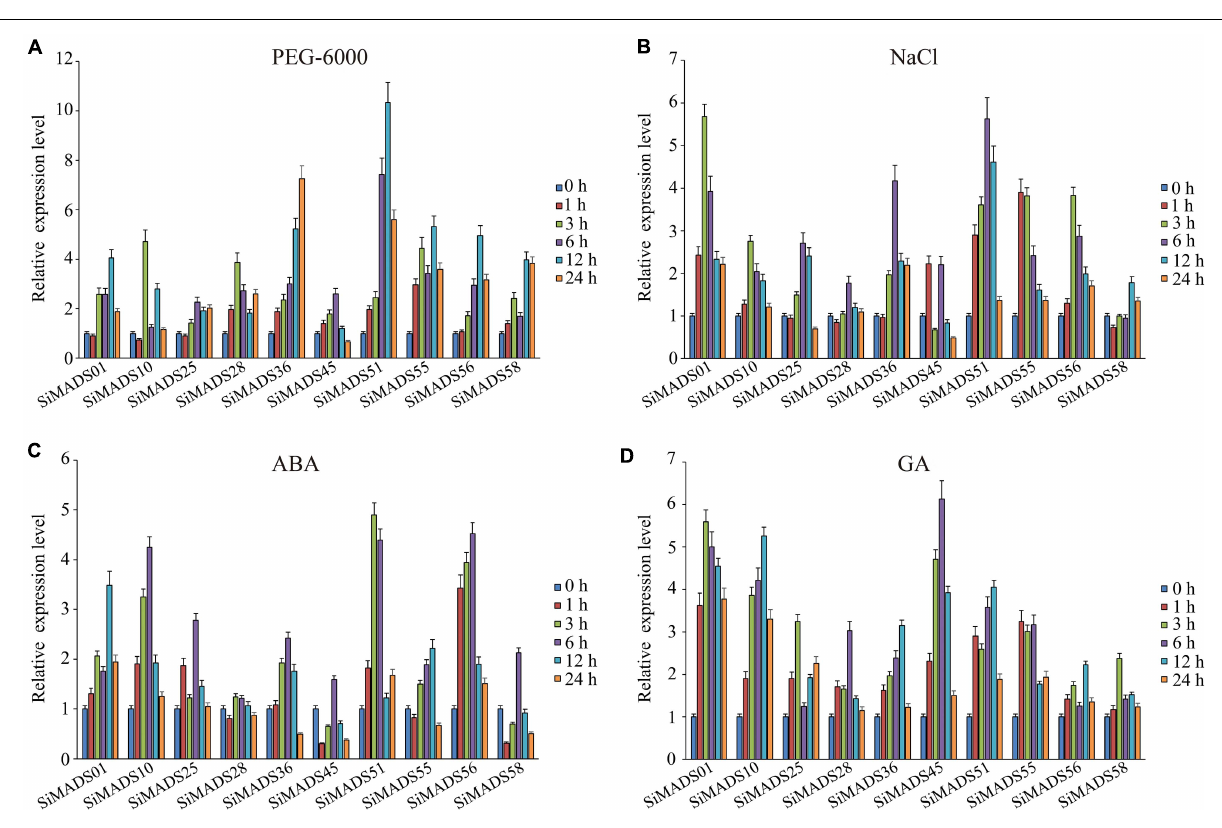
and 6 h, respectively, while expression of the SiMADS28 gene increased only slightly in response to ABA ( < 2-fold) ( Figure 6C